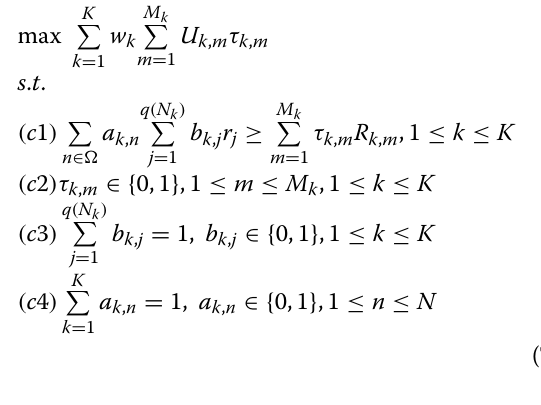
Table 2 Calculation of ψ Step 1 Calculate the location of the starting point of the η th MB of